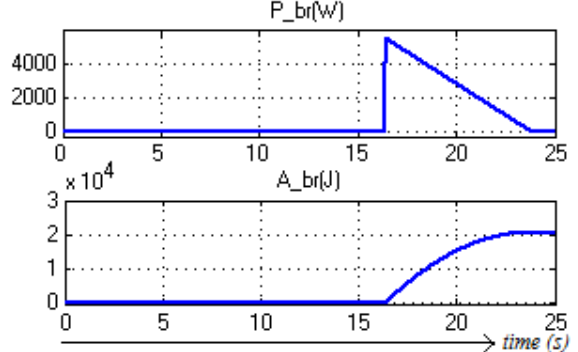
Fig. 6. Simulation diagrams of braking power and energy.